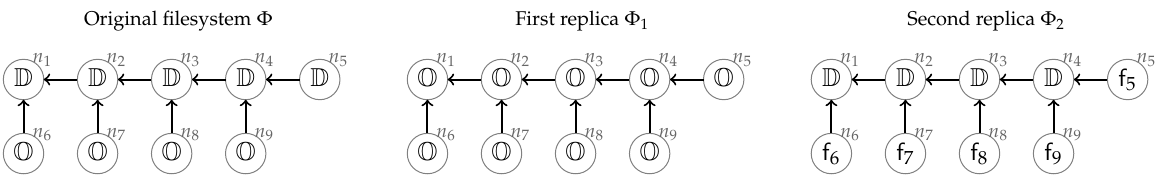
Figure 3. Illustrating the update detector. The nodes are, from left to right, n 1 to n 5 in the top row, and n 6 to n 9 in the bottom row. The first replica deletes all directories, the second replica stores file content f i at node n i